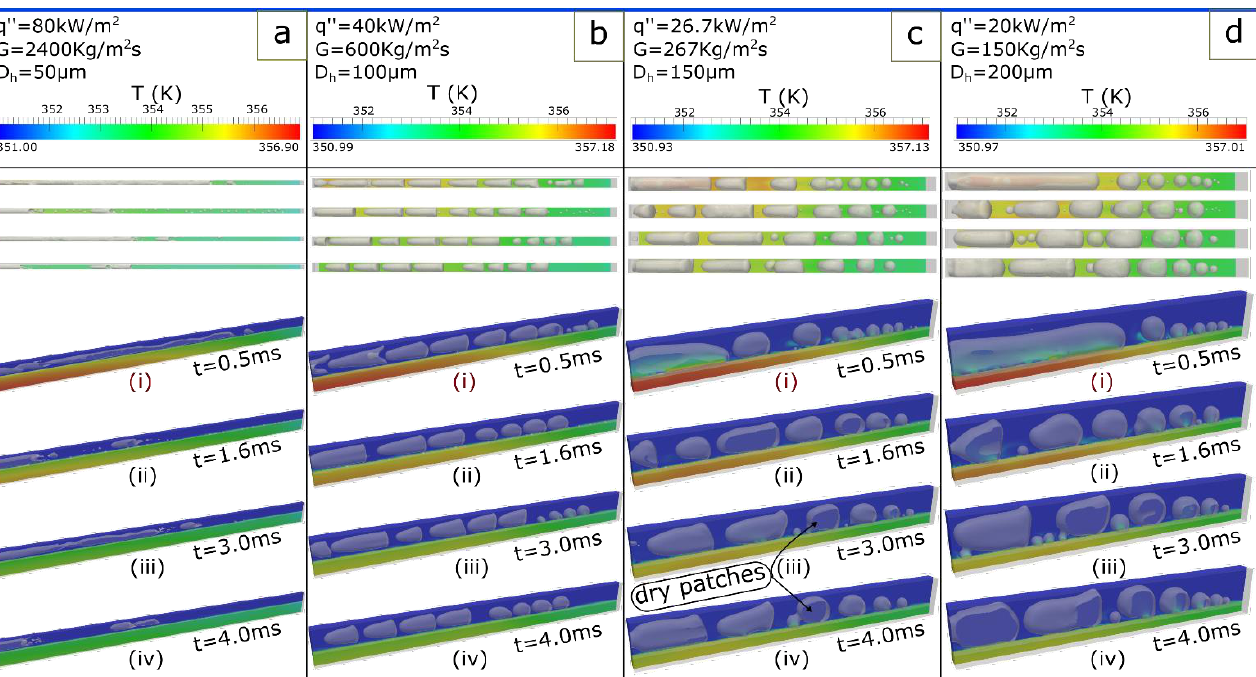
Figure 2. Numerical flow visualisation results for constant 𝑄 = 7.20 × 10 −3 W and 𝑉̇ = 9.1611 × 10 −9 m 3 /s . Four common time instants are shown for all cases, whereas at the top of each column, the heat flux, mass flux, and hydraulic diameter is shown, for each examined case ( a – d ).